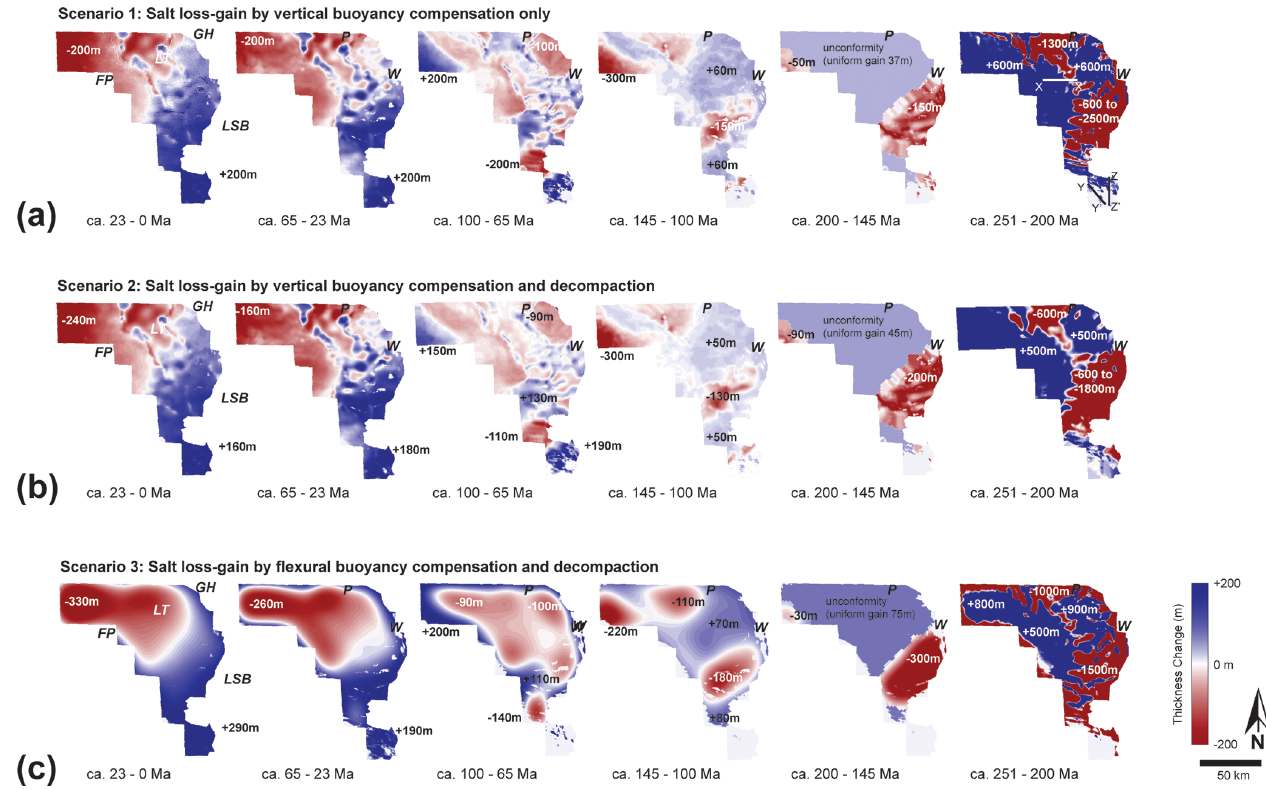
Figure 7. Differences calculated between successive pairs of isopachs of Fig. 6. (a) Salt loss–gain plot of backstripping scenario 1. (b) Salt loss–gain plot of backstripping scenario 2. (c) Salt loss–gain plot of backstripping scenario 3. Note similarity between vertical buoyancy compensation of backstripping scenarios 1 and 2 documenting limited significance of decompaction. Note pronounced difference between flexural buoyancy compensation (c) and vertical balancing (a, b) between recent times and the Early Cretaceous (145–100Ma). Late Cre- taceous salt gain pronounced in salt structures above LT boundary faults. Two-dimensional restoration (scenario 2) extracted along sections X – X (cid:48) and Z – Z (cid:48) (see a , 251Ma) shown in Fig.